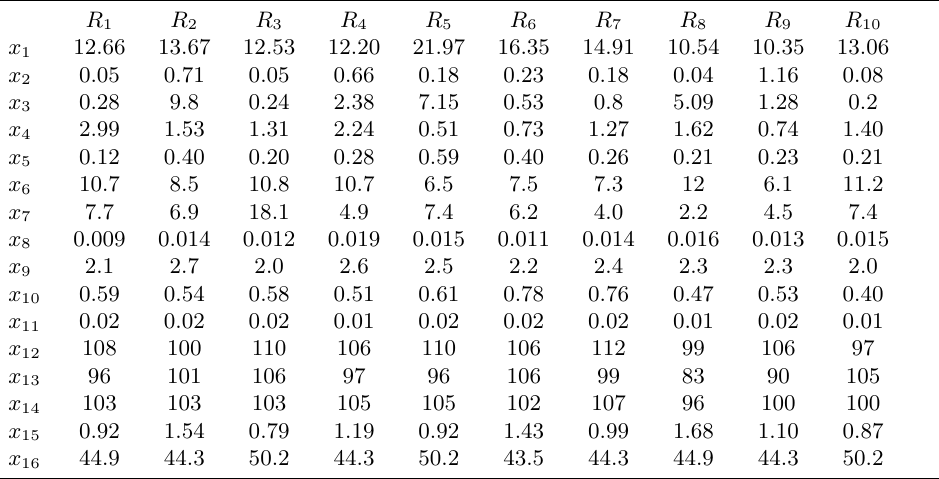
Table 4: Input data for assessing the economic security of